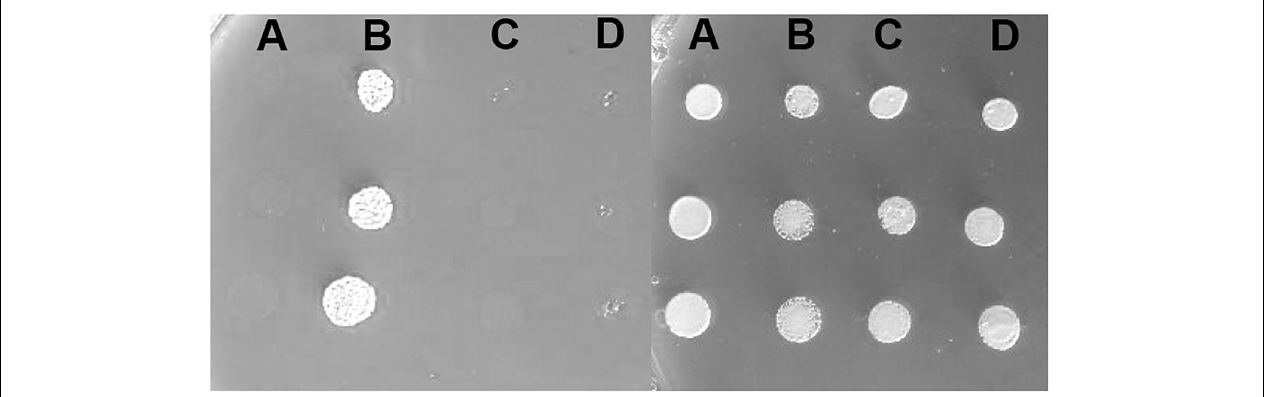
FIGURE 5 | Complementation of the ccc2 (cid:49) iron requiring phenotype on agar plates. Left panel: The exon 10 and exon 15 missing variants were investigated for their ability to complement the high iron requirement of a ccc2 (cid:49) yeast strain by plating cells on agar plates containing the iron chelator ferrozine. (A) ccc2 (cid:49) yeast cells expressing no ATP7A (empty vector). (B) ccc2 (cid:49) yeast cells expressing wild-type ATP7A . (C) ccc2 (cid:49) yeast cells expressing ATP7A variant missing exon 10. (D) ccc2 (cid:49) yeast cells expressing ATP7A variant missing exon 15. Right panel: To control for cell viability, each yeast strain was also spotted on iron-containing agar plates.